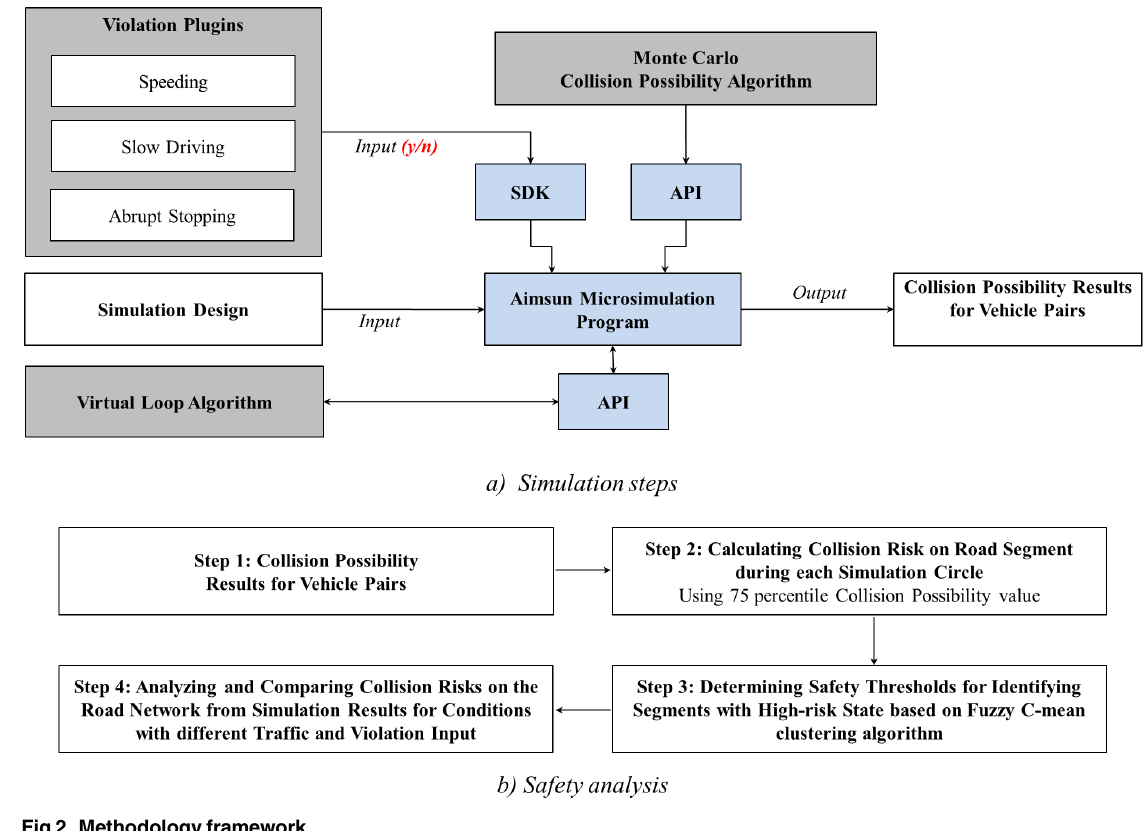
Fig 2. Methodology